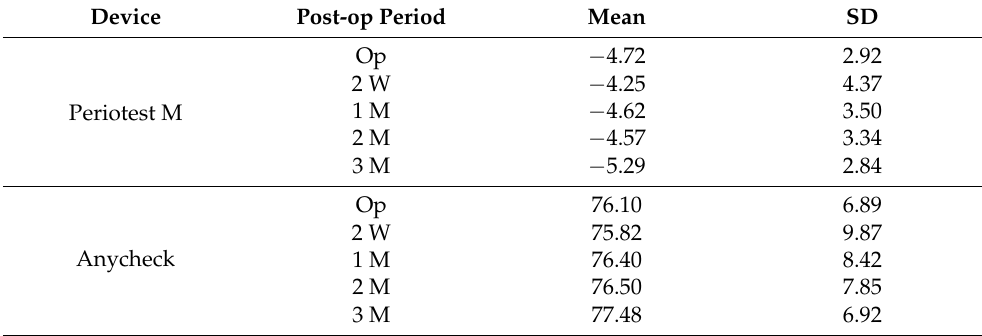
Table 2. The mean value and standard deviation of measured stability at each follow-up period. Device